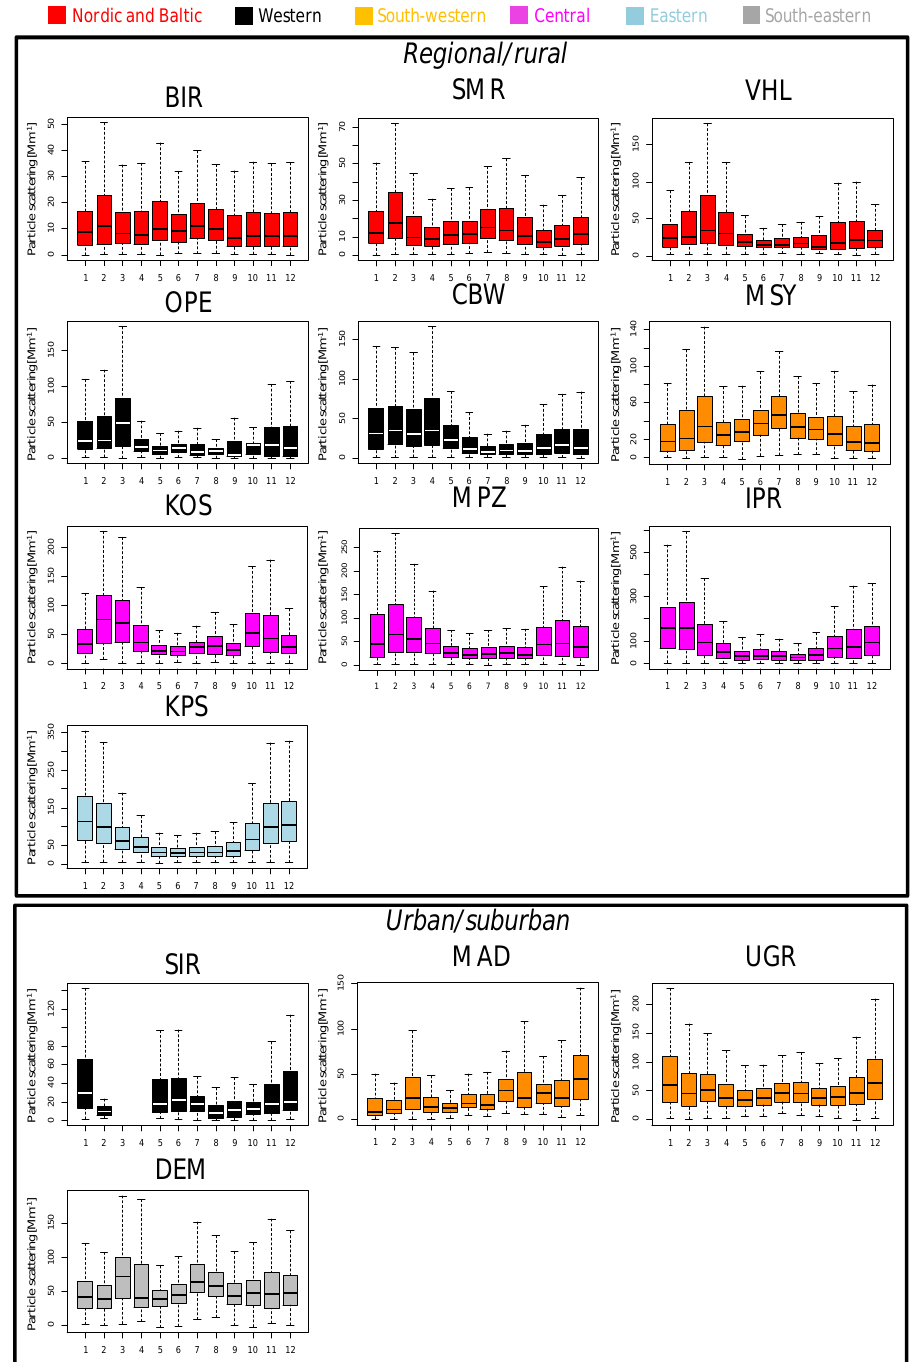
Figure 6. Seasonal cycles of σ sp (Mm − 1 ) measured in the green nephelometer